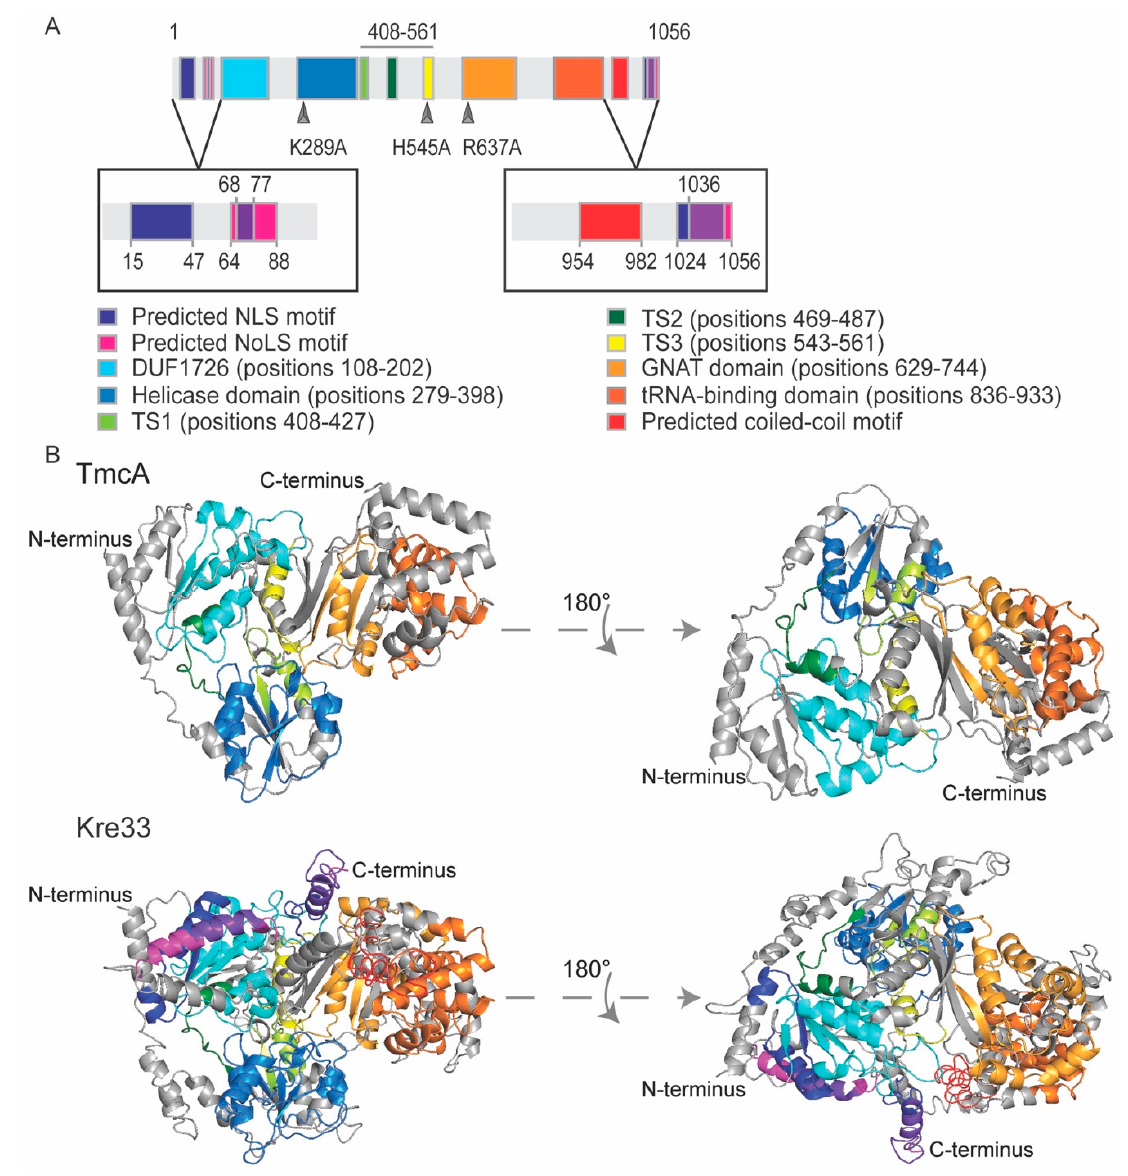
Figure 2. Conserved domains and motifs of Kre33. ( A ) Representation of yeast Kre33 highlighting the conserved domains / motifs. From left to right, the N-terminal extension (NTE), containing putative nuclear localization signal (NLS) and nucleolar localization signal (NoLS) motifs, colored in dark blue and magenta, respectively. Overlapping NLS and NoLS regions are shown in purple. The NTE is followed by a domain of unknown function called DUF1726 (light blue), a helicase domain (blue), three TmcA-specific motifs (TS1, TS2 and TS3) colored respectively in light green, dark green and yellow, a N -acetyltransferase domain (orange) and a possible tRNA-binding domain (paprika). These highly conserved domains precede a C-terminal extension (CTE) harboring a putative coiled-coil motif (red) followed by the NLS (blue) and NoLS (magenta), with overlapping regions in purple. Point mutations generated by Sharma et al. [22] are indicated. ( B ) Tridimensional representation of bacterial TmcA and yeast Kre33. Structures were modeled with I-TASSER [101]. Conserved motifs were colored using PyMOL with the color code used in (A).